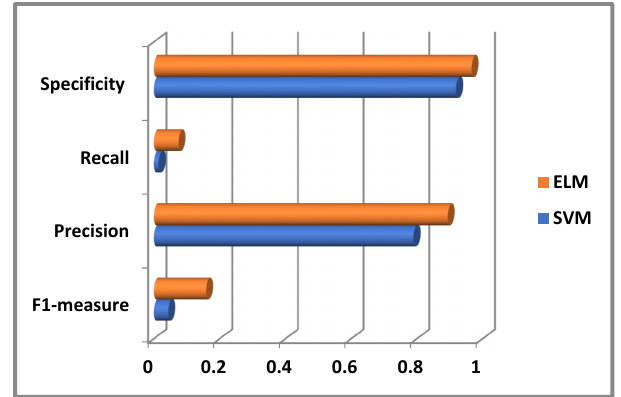
Figure 8. Specificity, Recall, Precision, and F1 ‐ measure comparison .